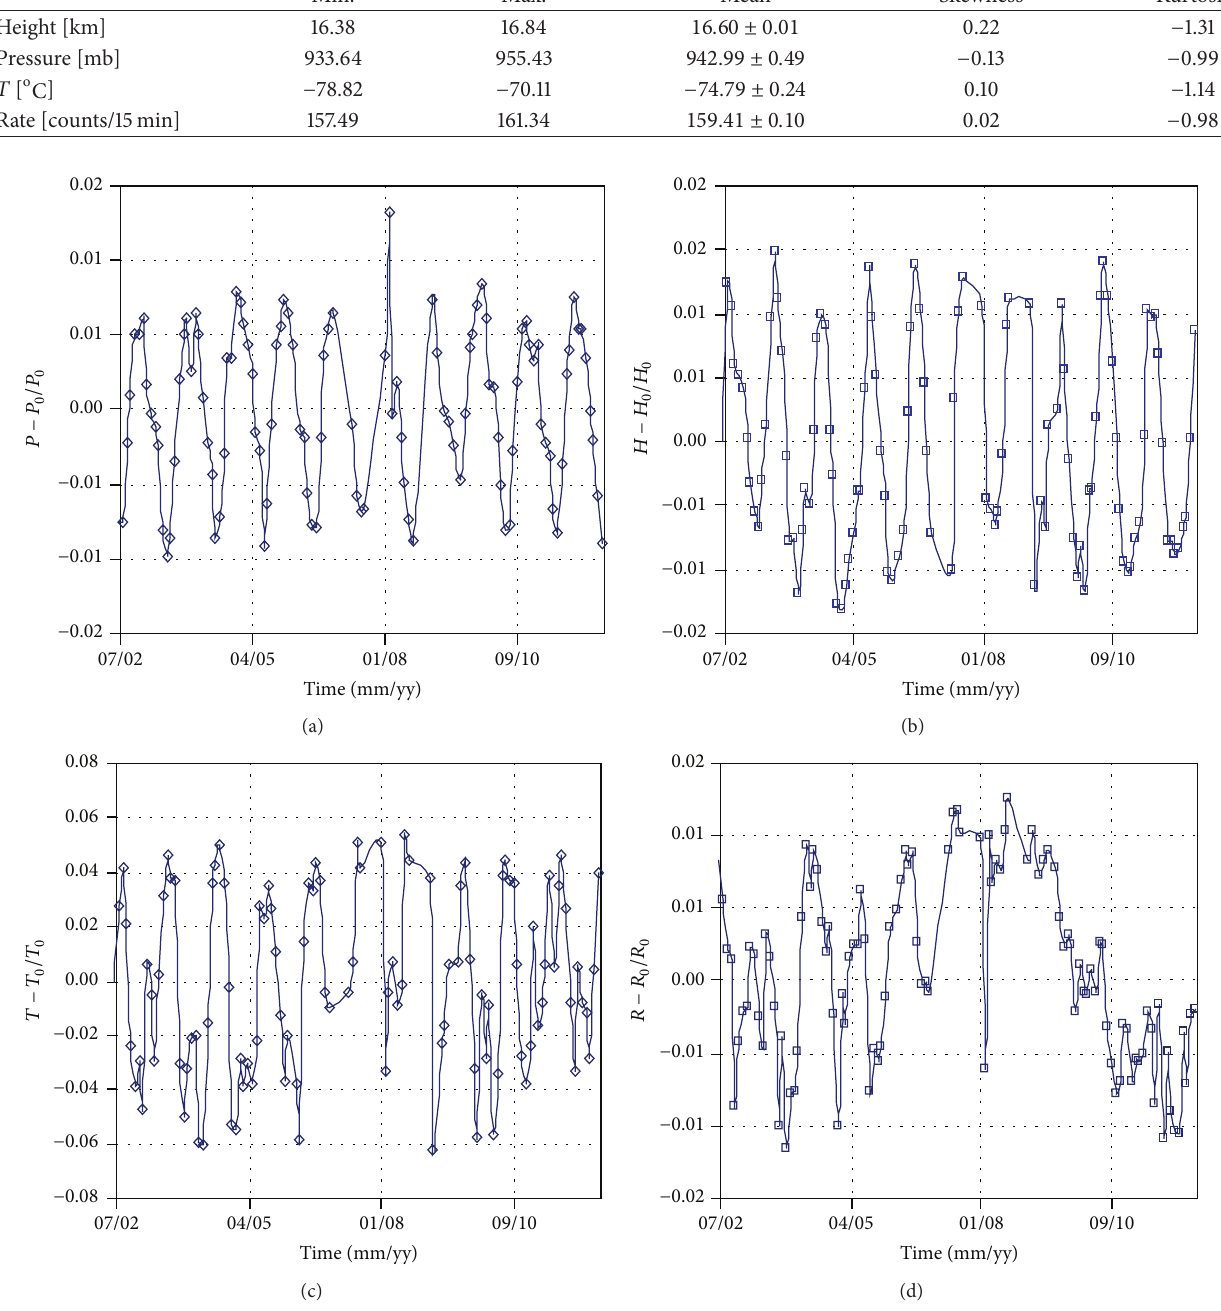
Figure 1: Time series of deviations of the (a) atmospheric pressure, (b) level of maximum production, (c) temperature at that level, and (d) muon counts, from their mean values during the 11